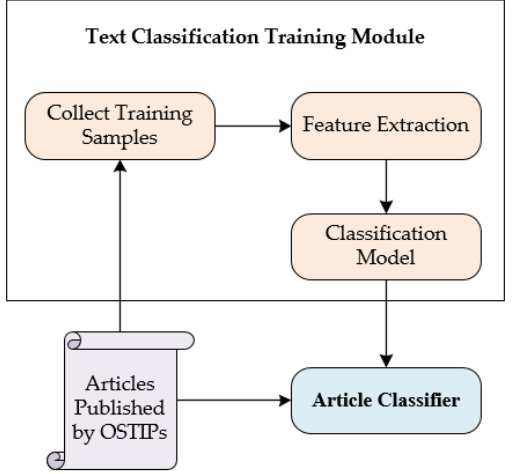
Figure 4. Framework of the article classifier.